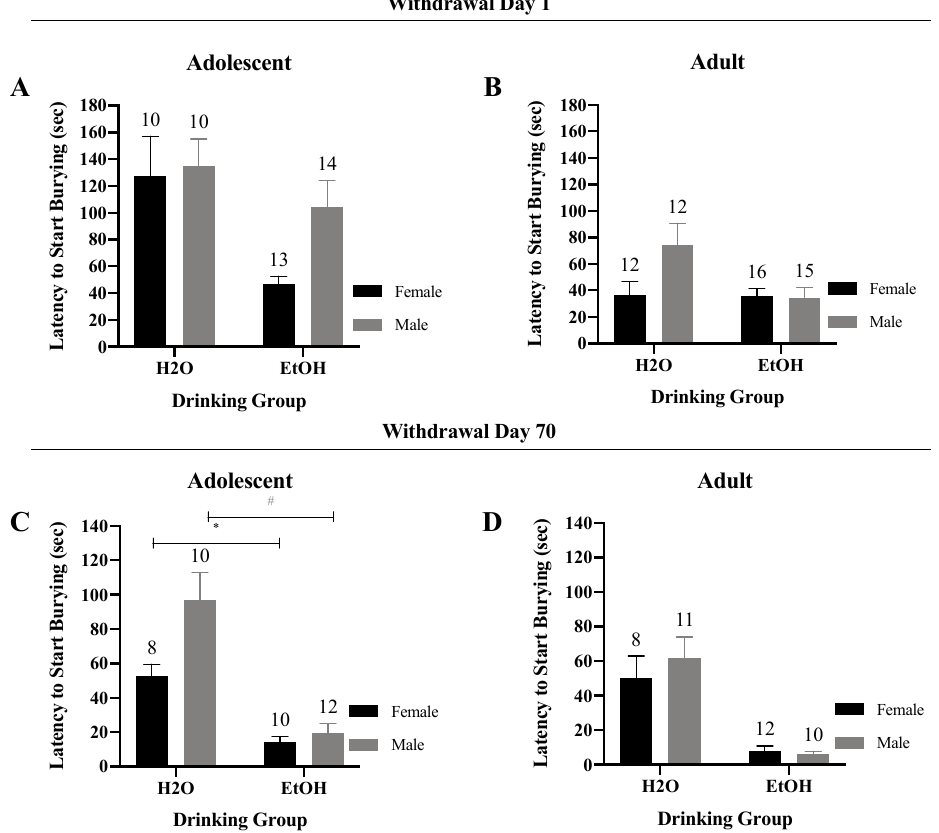
Figure 6. Summary of the results for the Sex × Drinking ANOVA observed for the latency to start burying marbles in the marble-burying test. ( A ) Depiction of the results for the adolescent-onset mice at 1-day withdrawal. ( B ) Depiction of the results observed for the adult-onset mice at 1-day withdrawal. ( C ) Depiction of the Sex × Drinking interaction for the adolescent-onset mice at 70-days withdrawal. ( D ) Depiction of the results for the adult-onset mice at 70-days withdrawal. The data represent the means ± SEMs for the numbers of mice indicated in each panel. * p < 0.05 for female H2O vs. female EtOH; # p < 0.05 for male H2) vs. male EtOH.